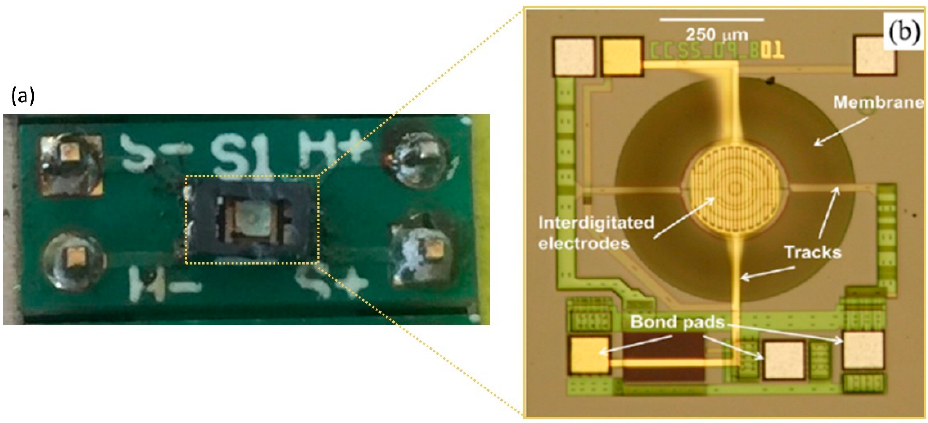
Figure 2. Photographs of a metal oxide device, ( a ) daughter for MOX sensor with DFN (dual-flat no-leads) package (marked with dotted line) and ( b ) microscopic image of the bare micro-hotplate, provided by ams Sensors Ltd (Cambridge, UK).